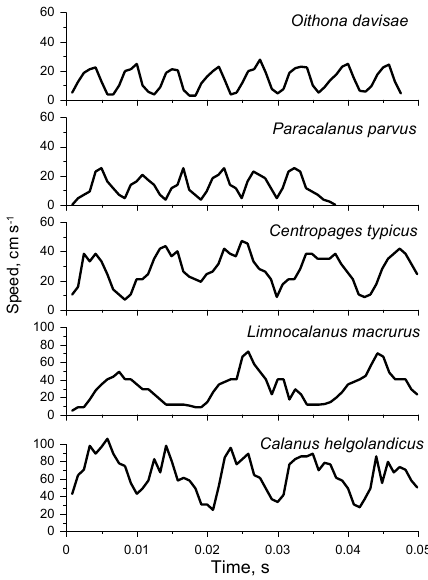
Figure 6. Instantaneous speeds of 5 species of copepods during the escape reaction.